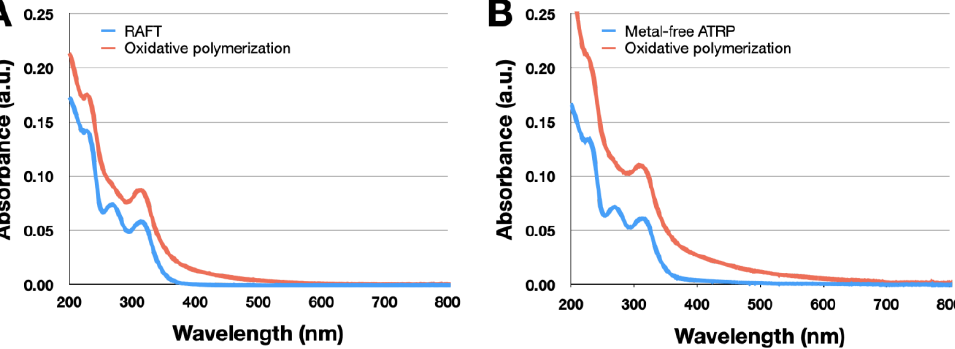
Figure 5. UV – VIS spectra before and after self-template oxidative polymerization registered for poly( St-D - alt - Ma-A ) brushes obtained via ( A ) RAFT and ( B ) PTH-ATRP.